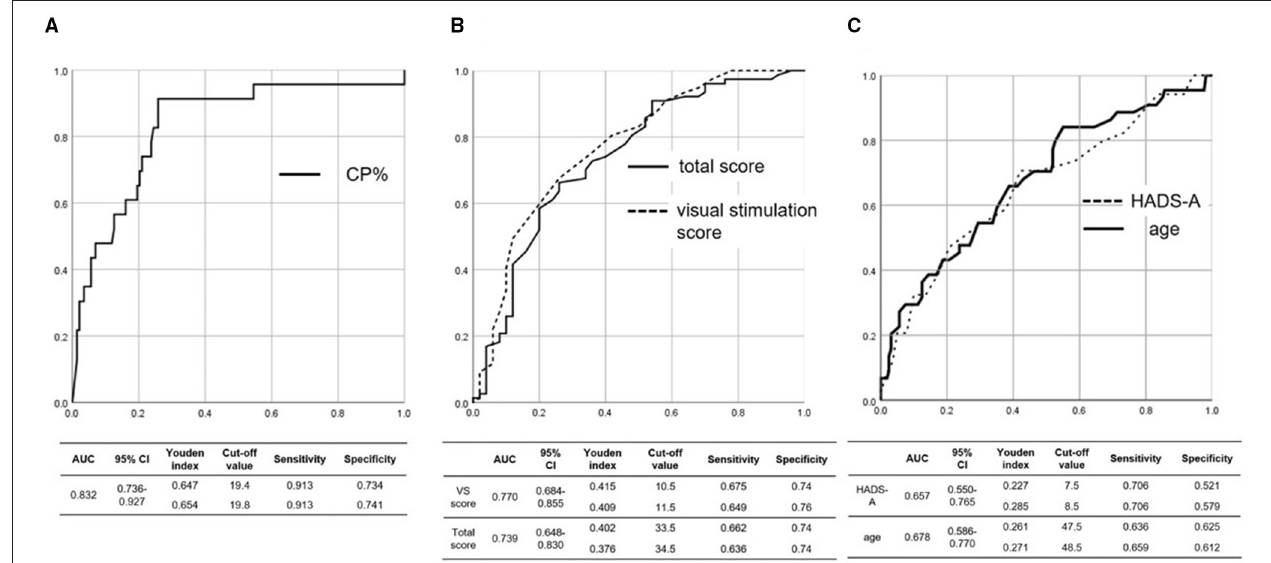
FIGURE 2 | ROC curve for the (A) CP%, (B) total and visual stimulation scores of the NPQ, and (C) age and HADS-A score. (A) The AUC of the ROC curve for the CP% was 0.832, and a CP% of 19.8 had the best sensitivity (91.3%) and specificity (74.1%) for diagnosing UVH. (B) The AUC of the ROC curve for the visual stimulation score and total score of the NPQ was 0.770 and 0.739, respectively, and visual stimulation score and total score of the NPQ of 10.55 and 33.5, respectively, had the best sensitivity (visual stimulation score of 10.5: 67.5%; total score of 33.5: 66.2%) and specificity (visual stimulation score of 10.5: 74.0%; total score of 33.5: 74.0%) for diagnosing PPPD. (C) The AUC of the ROC curve for age and the HADS-A score was 0.678 and 0.657, respectively, and age and HADS-A score of 48.5 years and 8.5, respectively, had the best sensitivity (age of 48.5 years: 65.9%; HADS-A score of 8.5: 70.6%) and specificity (age of 48.5 years: 61.2%; HADS-A score of 8.5: 57.9%) for diagnosing CDA. ROC, receiver operating characteristic; NPQ, Niigata PPPD questionnaire; CP%, percentage of canal paresis; HADS-A, anxiety score on the hospital anxiety and depression scale; AUC, area under the curve; PPPD, persistent postural-perceptual dizziness; CDA,